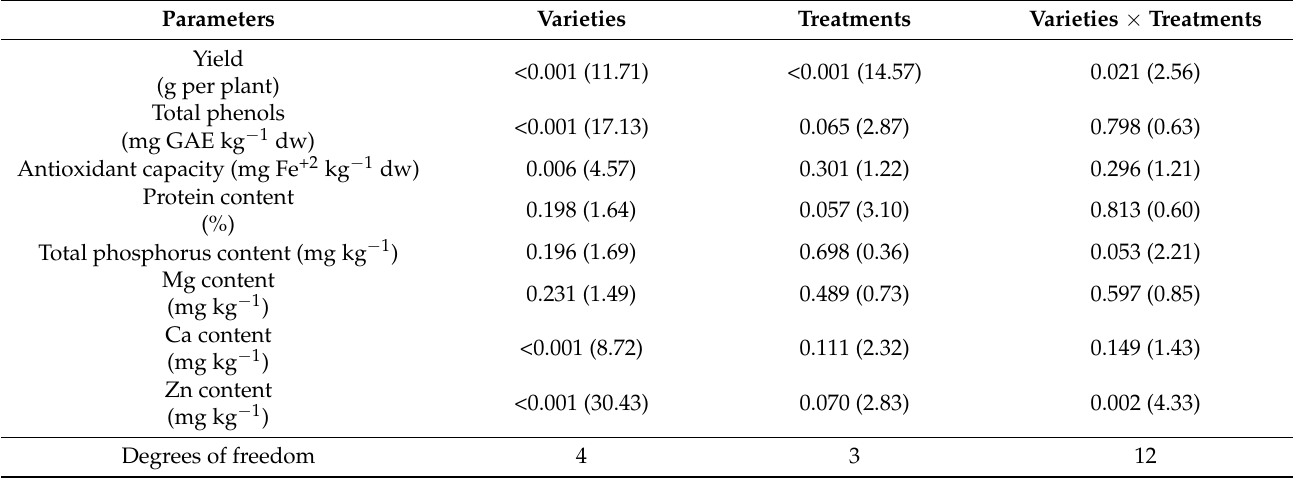
Table 1. Analysis of variance (ANOVA) table with the effects on different local varieties, of treatments, and of the interaction of variety and treatments on yield and nutraceutical properties of Venetian bean ( P. vulgaris ) local varieties cultivated in a rain-out shelter between March and August 2020, except Fasolo del Diavolo that did not produce seeds. The p -values are followed by the F-values in